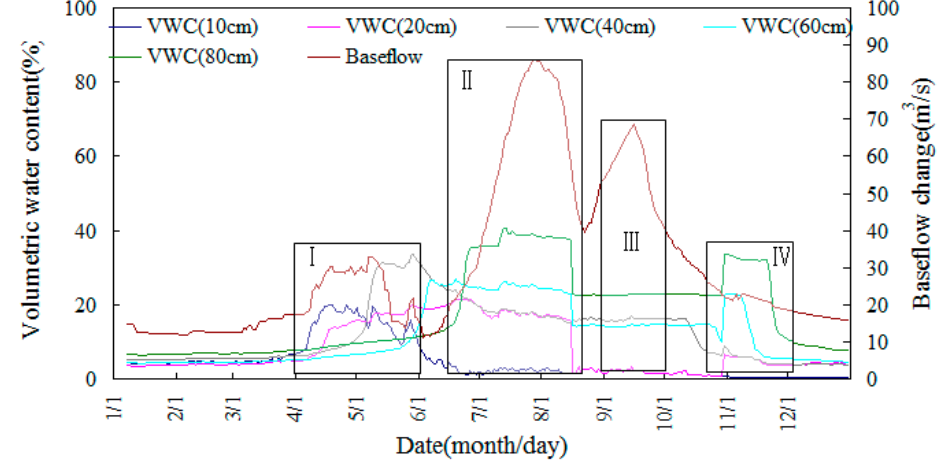
Figure 12. The processes of the VWC at different soil depths, and the basin baseflow during the four freeze-thaw periods.